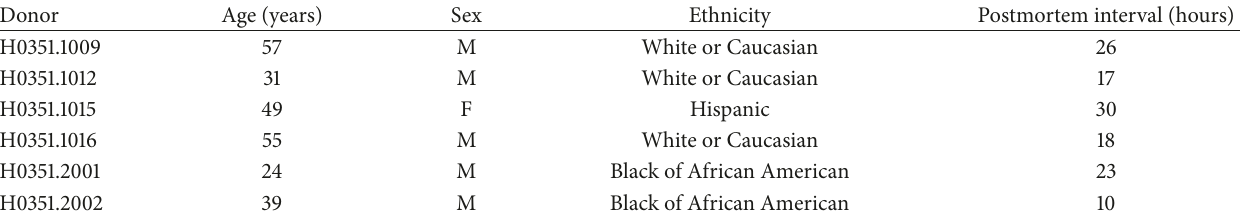
Table 2: Summary patient characteristics from Allen Human Brain Atlas [26] (http://human.brain-map.org).